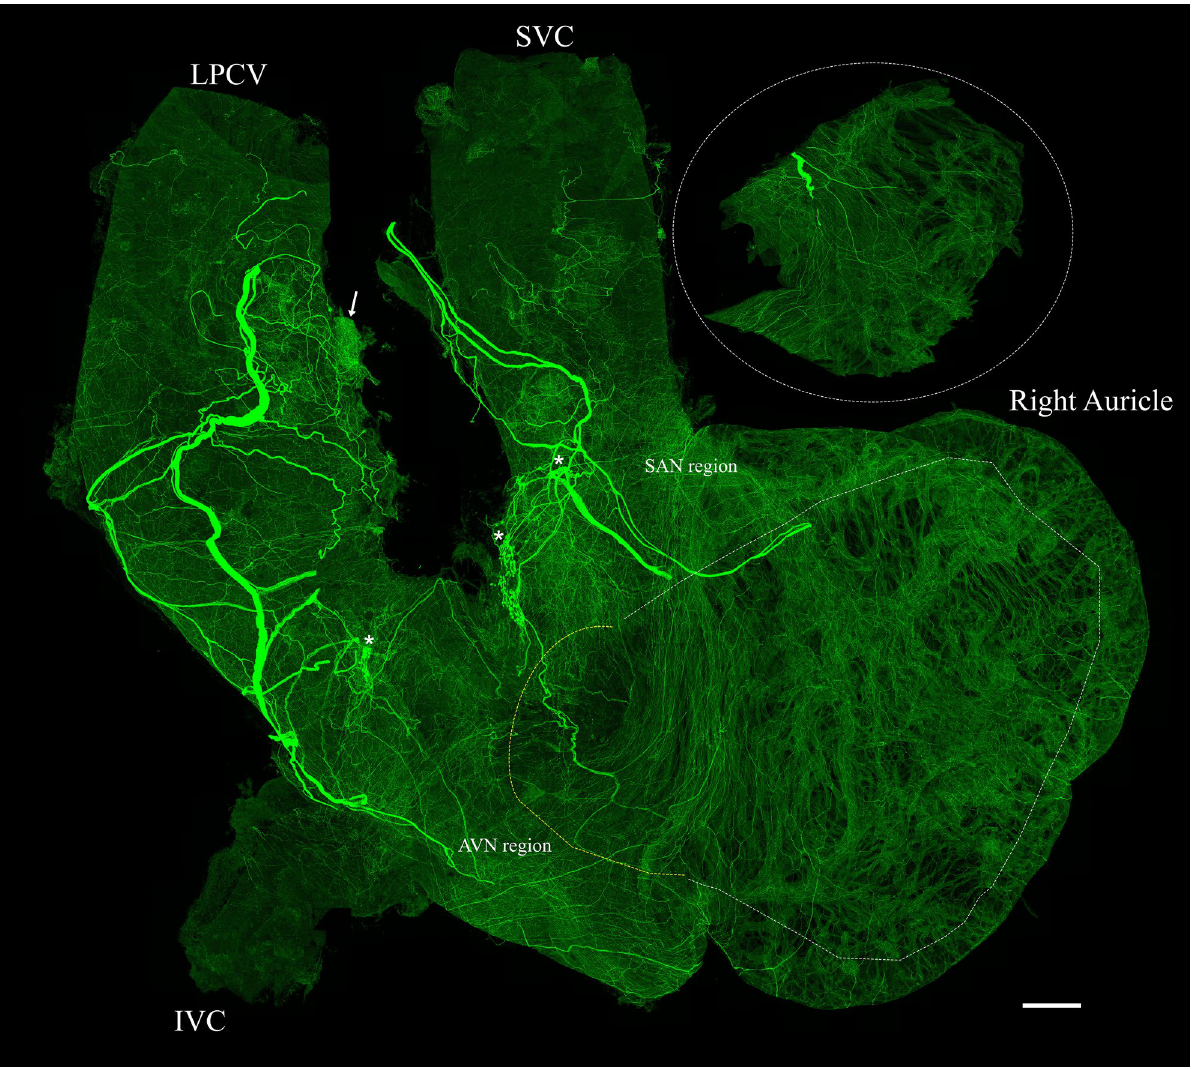
Figure 6. TH-IR axons in the RA of a representative mouse. The RA was separated from the LA and scanned using a 40 × oil objective lens. A montage of ~ 700 maximal projections in the RA showed large TH-IR bundles entered the atrium through the SVC and LPCV, traveled through the cardiac ganglia (asterisks), branched out to small axon bundles, and finally innervated the whole atrium with dense terminal varicosities. Intrinsic cardiac ganglia (asterisks), fat (arrow), white dotted line (boundaries of cut to separate the inner auricle), yellow dotted line (opening of the atrium) (Please zoom in 400 × to view details as well as see the following figures). RA right atrium, LPCV left precaval vein, SVC superior vena cava, IVC inferior vena cava, SAN sinoatrial node region, AVN atrioventricular node region. Scale bar: 500